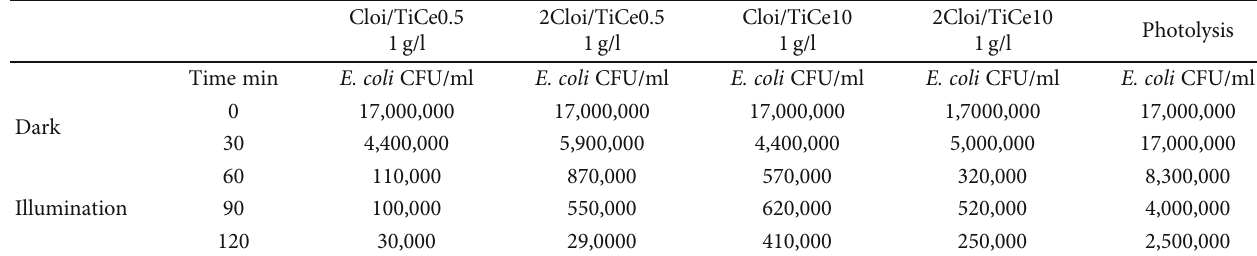
Table 3: Photocatalytic degradation of E. coli using di ff erent catalysts. Each value has been obtained twice, and the average value is included. The obtained deviation of each set of the experimental values was about fi ve